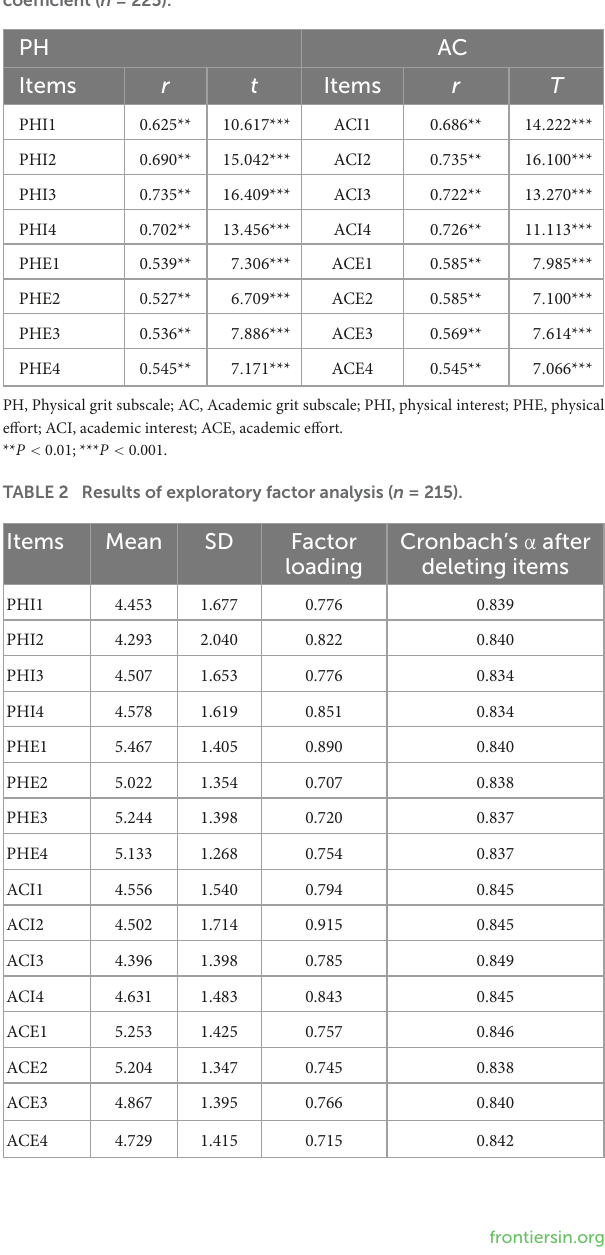
TABLE 1 Independent sample T -test and item-total correlation coefficient ( n = 225).